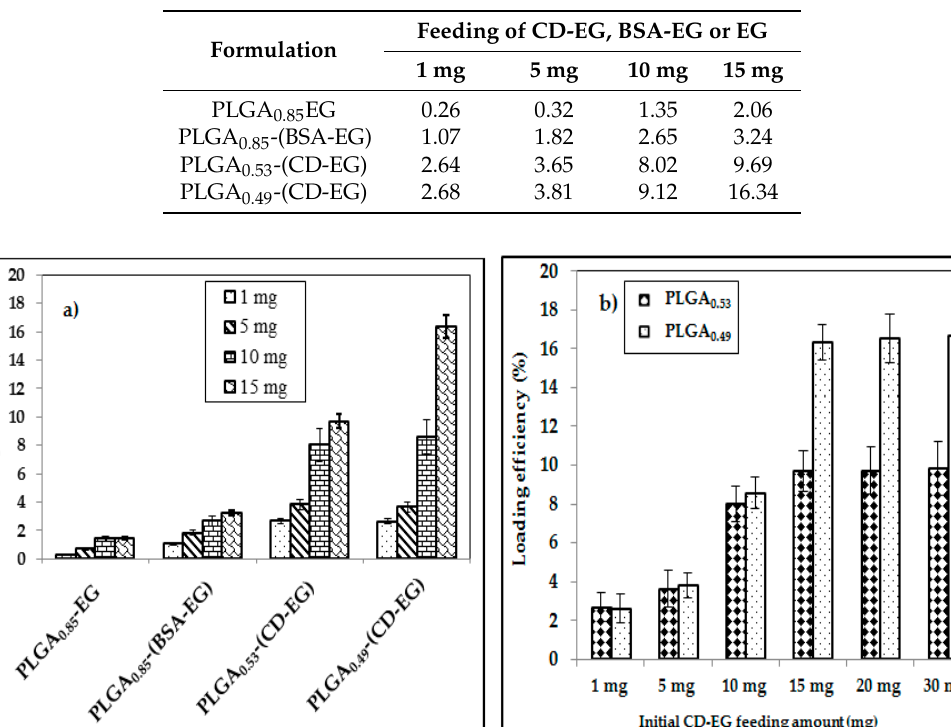
Figure 3. ( a ) Loading efficiency of various formulations of PLGA microspheres with different EG feeding amounts; and ( b ) optimization of the effects of the initial EG feeding amount on the loading efficiency of PLGA 0.53 -(CD-EG) and PLGA 0.49 -(CD-EG). Compared with PLGA microspheres containing BSA, PLGA 0.49 -(CD-EG) and PLGA 0.53